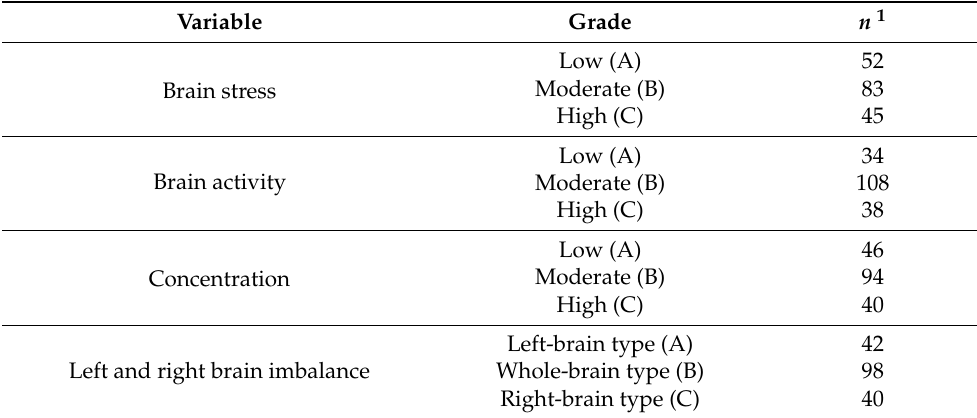
Table 2. Variables of the research subject classified by brain wave data.